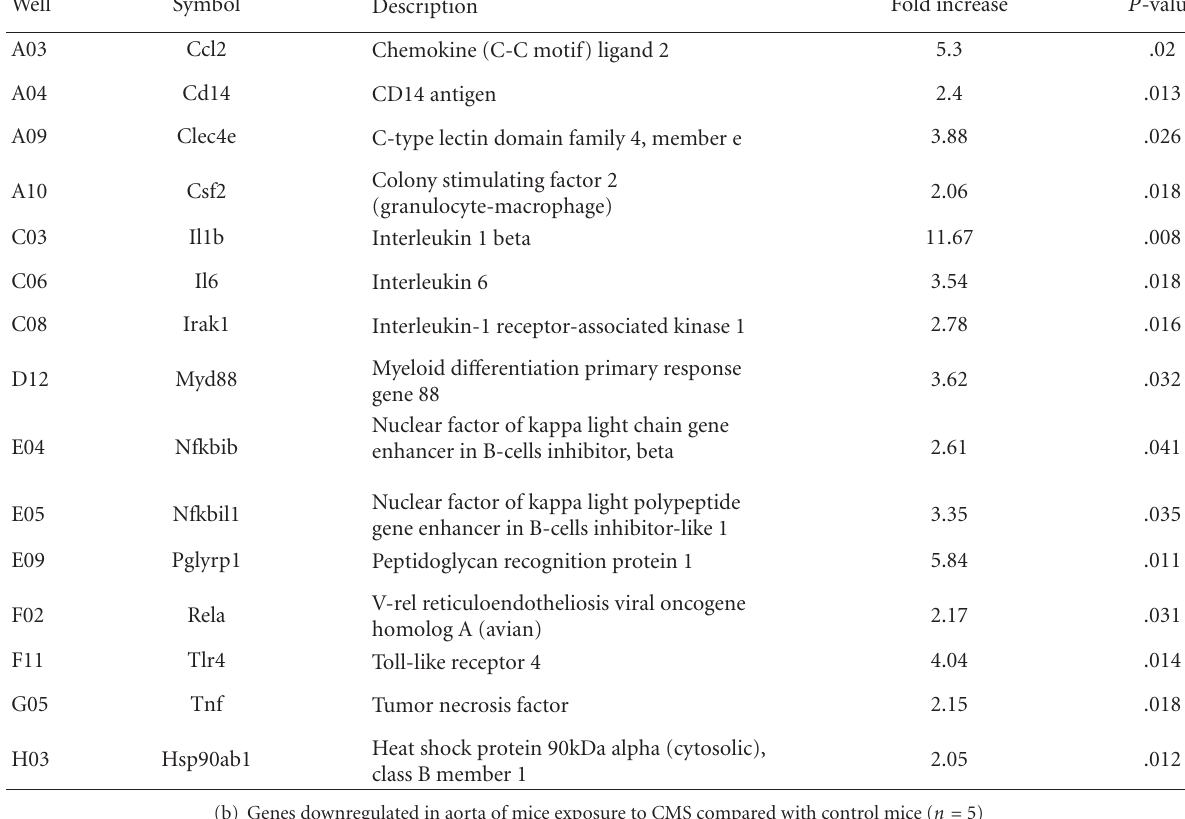
Table 2: CMS alters TLRs signaling pathway gene expression profile in aortas of apoE-/- mice. ApoE-/- mice 4 weeks old were subjected to a 24-hour CMS daily for 0, 4, 12 weeks. Mice were sacrificed, and aortas were harvested. Total RNA was extracted, and microarray analysis was determined as described under “materials and methods.” TLRs signaling pathway array consisting of 87 were used to analyze gene expression in aorta from mice with or without chronic mild stress. The microarrays were used according to the manufacturer’s instructions. The table showed gene expression changes ≥ 2.0-fold versus control. Calculate the fold change for each gene from control group to stress group as 2- ΔΔ Ct. Among 87 genes analyzed, 15 genes were upregulated, and 28 genes were downregulated by